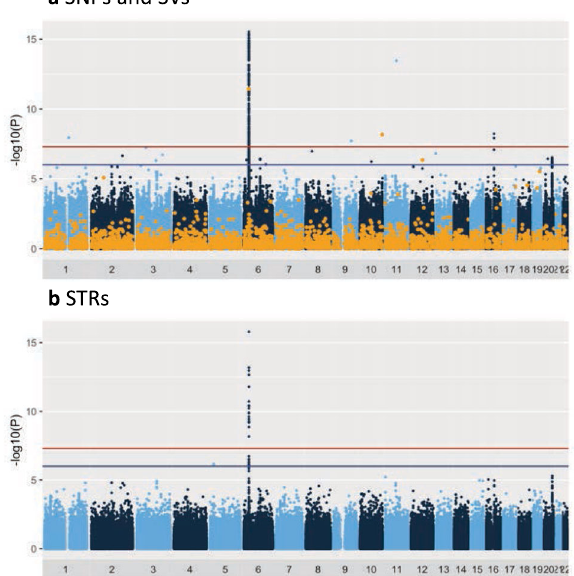
Fig. 1 Genome-wide association plot of samples from patients with CM-SJS/TEN with SOC. The negative logarithm of the p values of each variant (Y-axis) were plotted against genomic coordinates on each autosome (X-axis). Red and blue horizontal lines represent p values with 5 × 10 − 8 and 1 × 10 − 6 , respectively. a SNVs are colored dark blue and light blue, while SVs (INDELs, DELs, DUPs, MEIs, and INVs) are colored orange. b STRs are colored dark blue and light